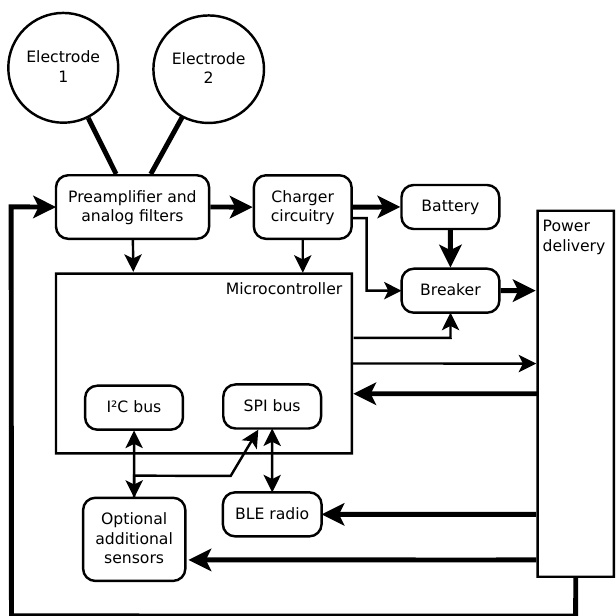
Figure 3. Hardware block diagram of the PCARD sensor. Thicker lines represent power delivery, while thinner lines represent signal